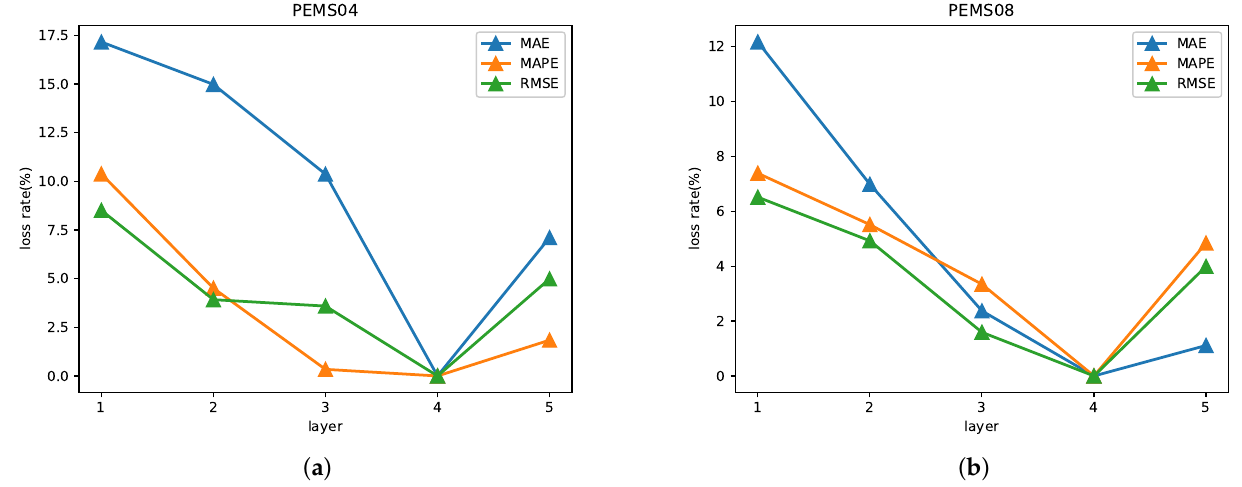
Figure 6. Loss variation rates for different LSTFGCNL layers on two datasets: ( a ) experiment loss change rate of different LSTFGCNL layers on PEMS04 dataset; ( b ) experimental loss change rate corresponding to different LSTFGCNL layers on PEMS08